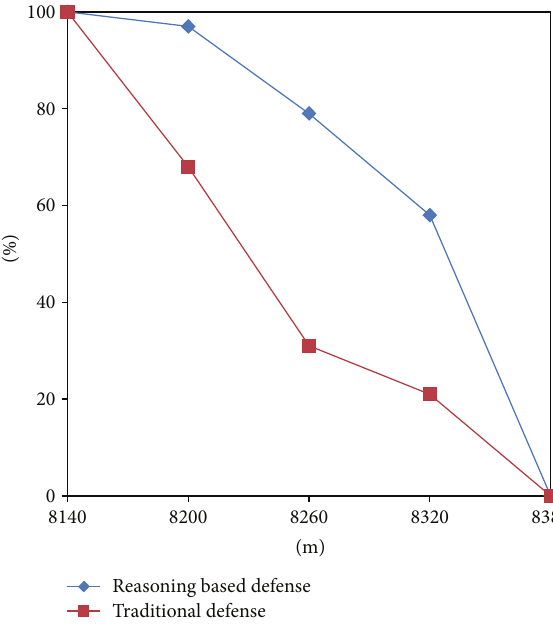
Figure 9: The reasoning 𝐸𝑀 , extended Fuzzy CLIPS as the reason- ing engine. Figure 10: Survival probability of target.